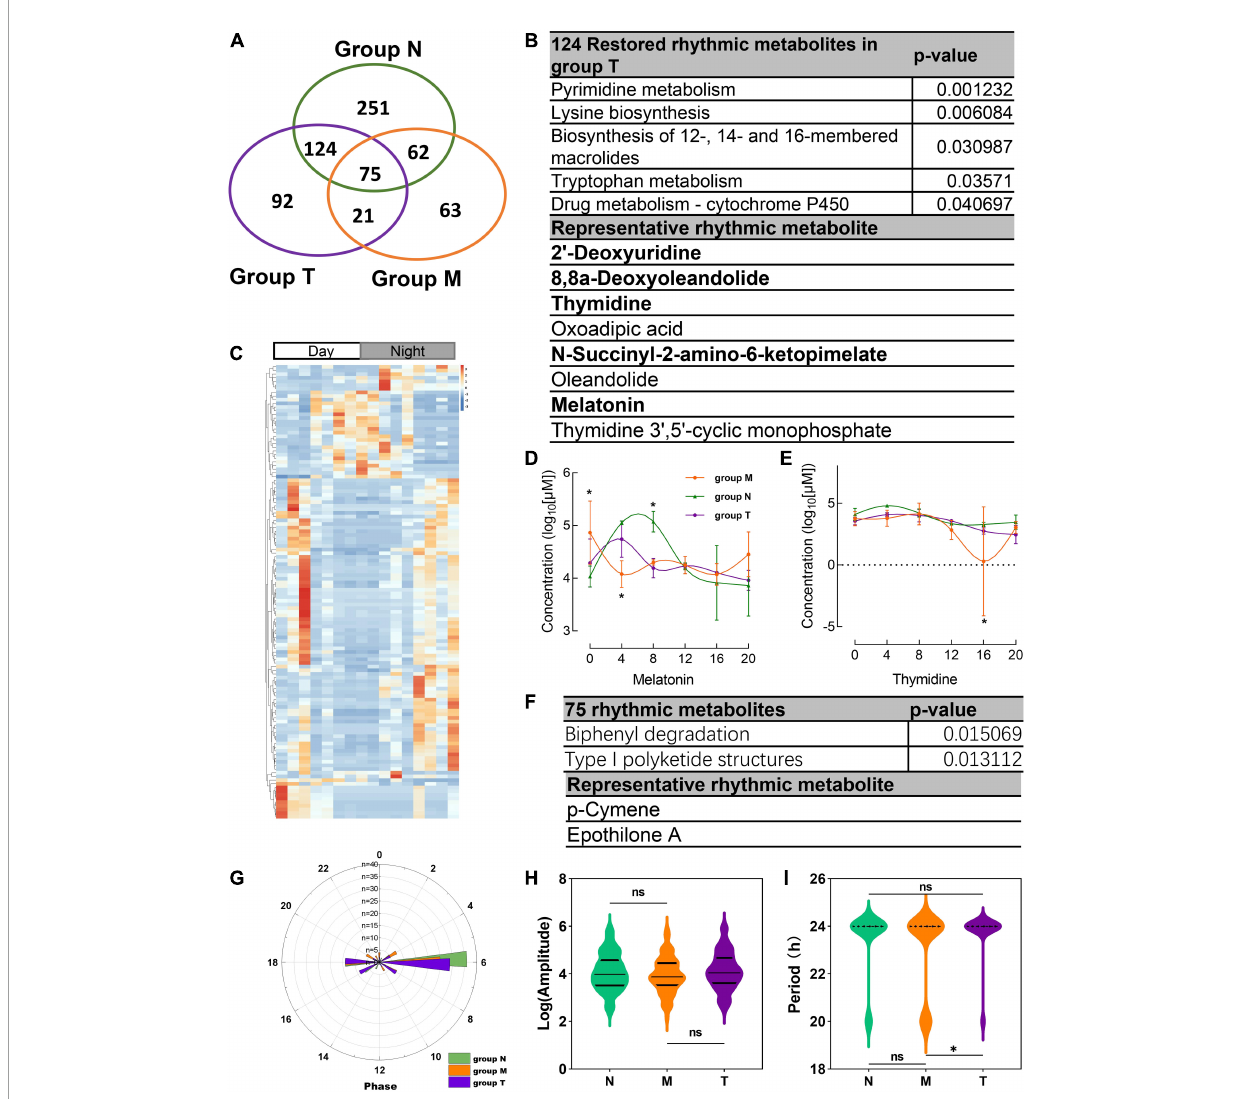
FIGURE5 Acupuncture restored rhythmic saliva metabolites and shared rhythmic metabolites analysis. (A) Venn diagram showing 688 rhythmic metabolites in three groups. (B) The KEGG pathway enrichment of acupuncture restored rhythmic salivary metabolites and representative metabolites. (C) Heatmap of 124 rhythmic metabolites in group T. The concentration of representative metabolites melatonin (D) , thymidine (E) . (F) Common shared metabolites in three groups enrichment and representative metabolites. (G) The circadian parameter of common shared metabolites in three groups phrase distribution. (H,I) The amplitude and period of the three groups. * p <